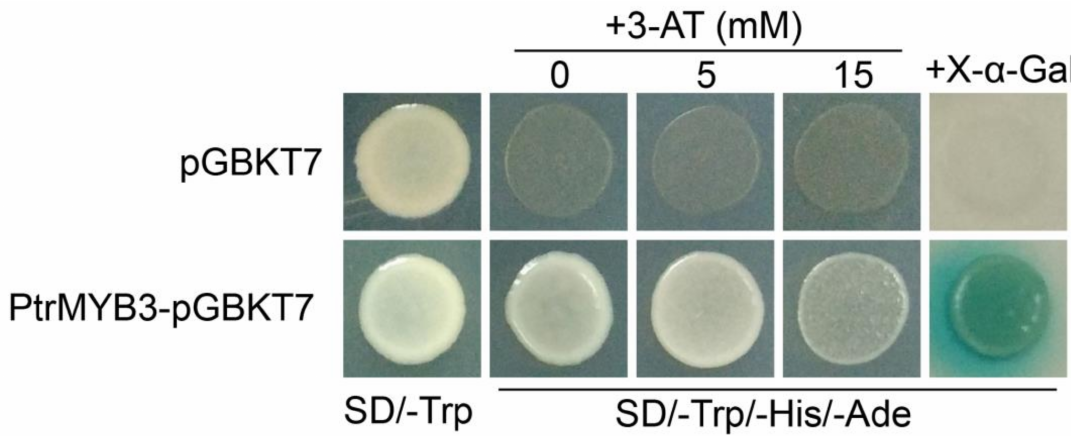
Figure 4. Transactivation assay of PtrMYB3. The representative images indicate yeast cells expressing pGBKT7 control plasmid (upper panels) or PtrMYB3-pGBKT7 fusion plasmid (bottom panels) under different selective growth mediums, including SD/-Trp or SD/-Trp/-His/-Ade with or without 3-AT and X- α